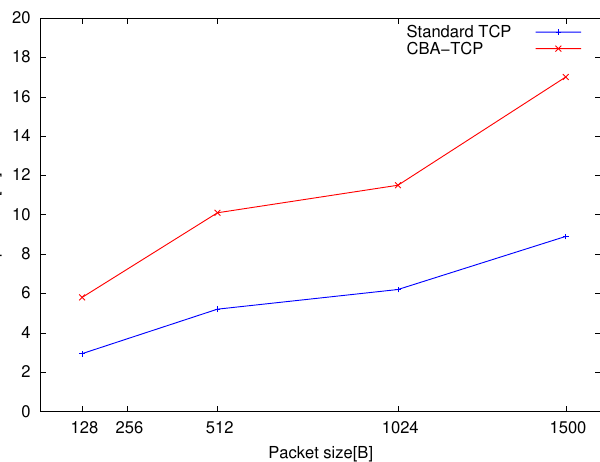
Figure 5. The Packet loss of the CBA-TCP vs. Standard